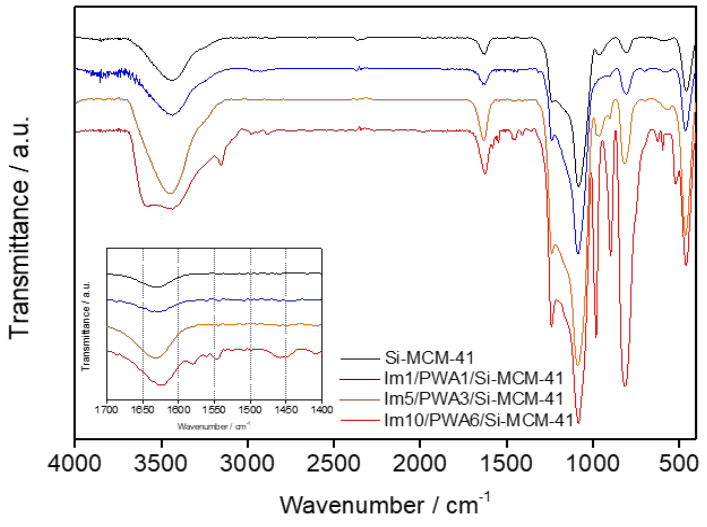
Figure 5. FT-IR spectra for Im(x)/PWA(y)/Si-MCM-41.